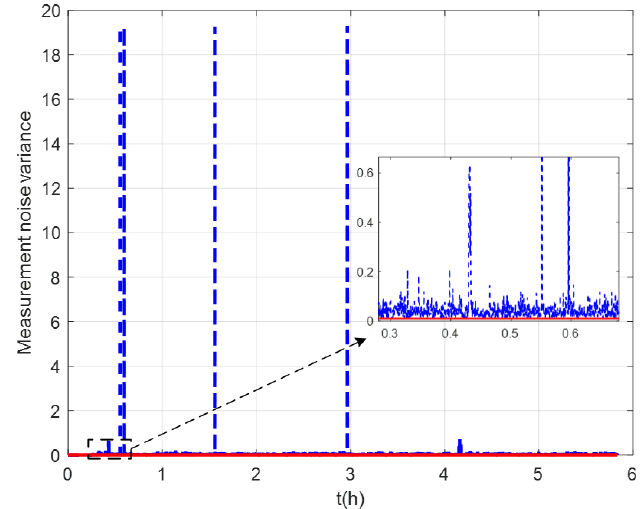
Figure 6. Values of measurement noise covariance.